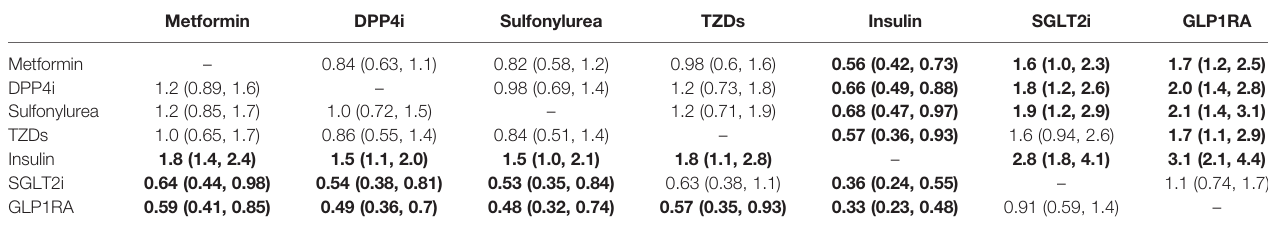
TABLE 3 | The results of Bayesian network